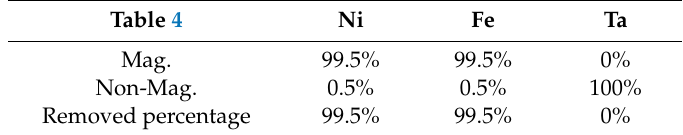
Table 4. Remove percentage of nickel and iron after magnetic separation.